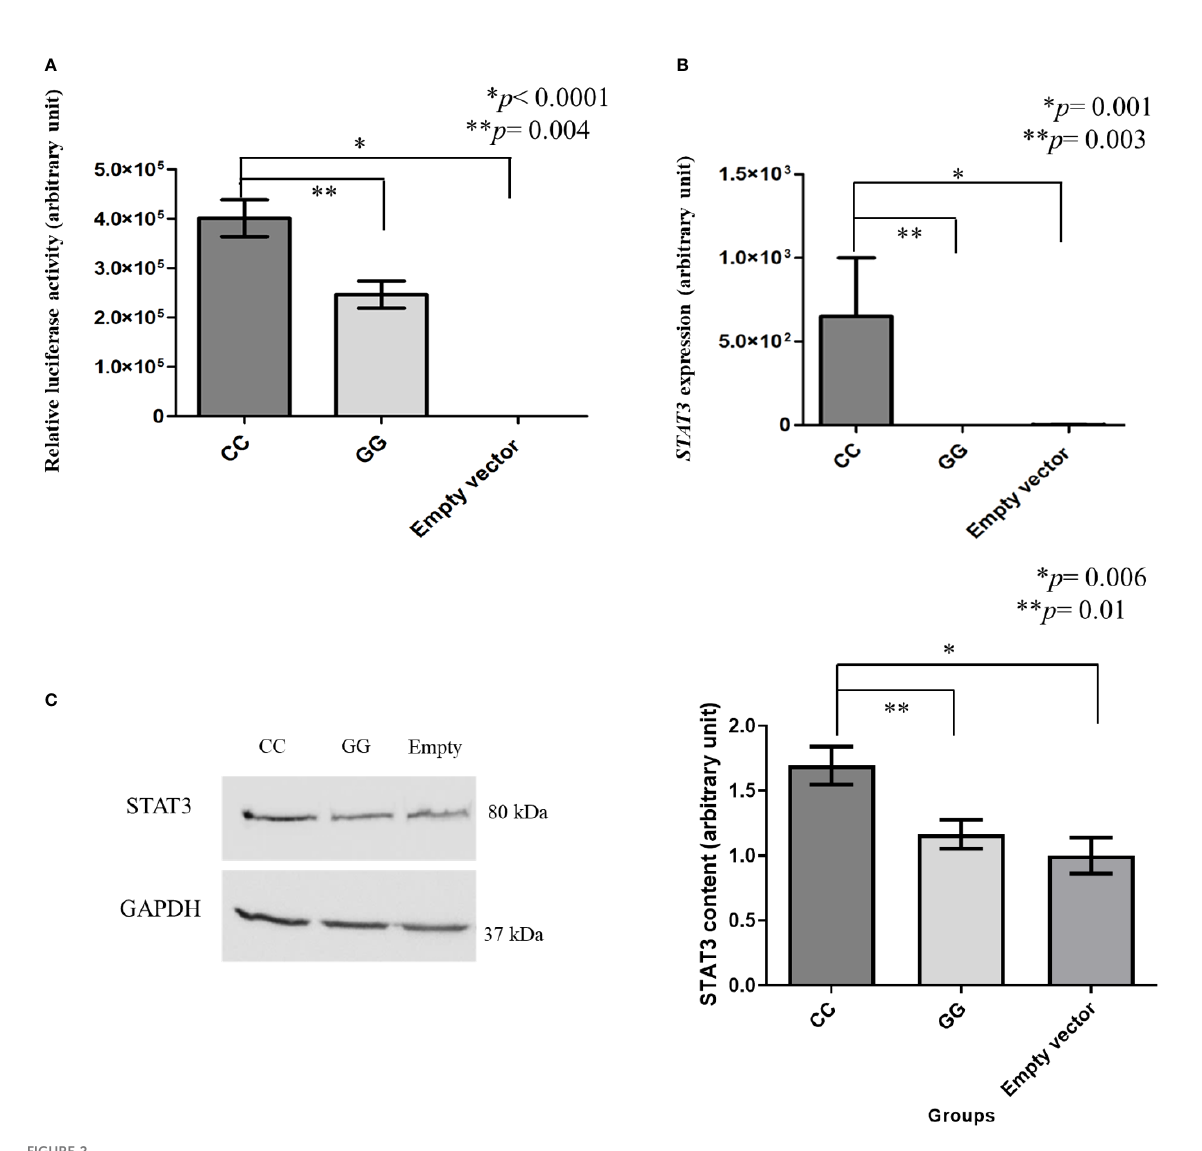
FIGURE 2 Luciferase activity and STAT3 expression measured by real-time polymerase chain reaction and STAT3 level measured by western blot in modi fi ed SKMEL-28 ( STAT3 c.-1937CC or GG genotype). Total proteins (50 µg) were analyzed by 10% sodium dodecyl sulfate polyacrylamide gel electrophoresis, and the separated proteins were transferred to nitrocellulose membranes. The membranes were blocked with 5% skimmed milk in phosphate-buffered saline (PBS-Tween) and incubated with speci fi c primary antibodies anti-STAT3 (Santa Cruz, USA) and anti-GAPDH (Santa Cruz, USA) overnight at 4°C. A horseradish peroxidase-conjugated goat anti-mouse IgG was used as the secondary antibody (Santa Cruz, USA). GAPDH was used as normalizer in the western blot experiments. ECL Western Blot Detection Reagents kit (GE Healthcare, USA) was used, and the intensities of the protein bands were quantitated using ImageJ software (National Institutes of Health, USA). The results are shown as means between groups. For the statistical tests, values with p < 0.05 were considered signi fi cant. SKMEL-28 cells with CC genotype presented a higher STAT3 luciferase activity than those with GG genotype [4,013.34 vs. 2,463.32 arbitrary units (AU)] and the one with empty vector (4,013.34 vs. 0.0122 AU) (A) , a higher STAT3 gene expression than those with GG genotype (649.20 vs. 0.03 AU) and the one with empty vector (649.20 vs. 2.11 AU) (B) , and a higher STAT3 protein level than in those with GG genotype (1.69 versus 1.16 AU) and the one with empty vector (1.69 vs. 1.00 AU) (C) . * and ** statistically signi fi cant